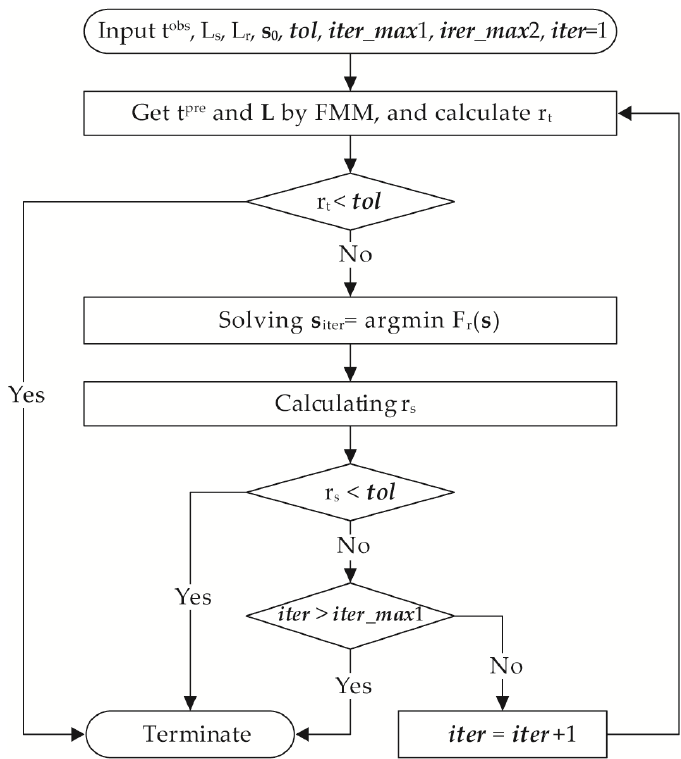
Figure 1. The flow chart of the ray-tracing tomographic inversion algorithm.